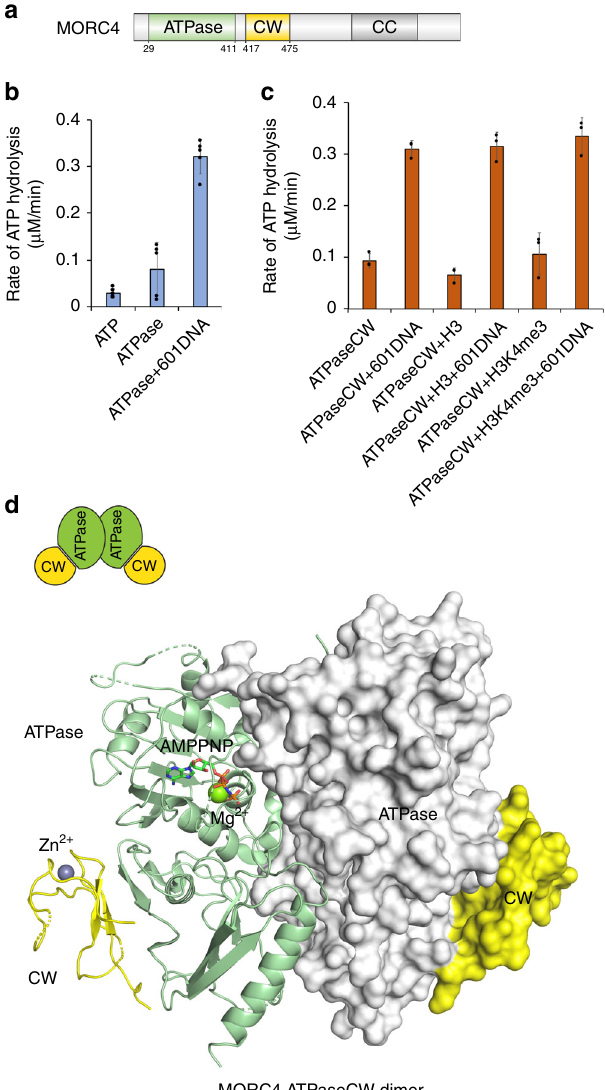
Fig. 1 MORC4 is an ATPase. a MORC4 domain architecture. The ATPase and CW domains are colored green and yellow, respectively. The ATPaseCW cassette construct contains aa 29 – 486 of MORC4 (Q8TE76). b , c Rates of ATP hydrolysis by the ATPase domain of MORC4 ( b ) and the ATPase-CW cassette of MORC4 ( c ). Data are represented as mean values + / − S.D. of at least three independent experiments ( n ≥ 3). Source data are provided in a Source Data fi le. d The crystal structure of the dimeric MORC4 ATPase-CW/AMPPNP complex. In protomer A, the ATPase domain and the CW domain are shown in a ribbon diagram and colored green and yellow, respectively. In protomer B, the surface representation of the ATPase domain (white) and the CW domain (yellow) is shown. The magnesium (green) and zinc (gray) atoms are shown as spheres. The AMPPNP molecule is in stick representation. Dashed lines represent residues and loops that are not de fi ned by electron